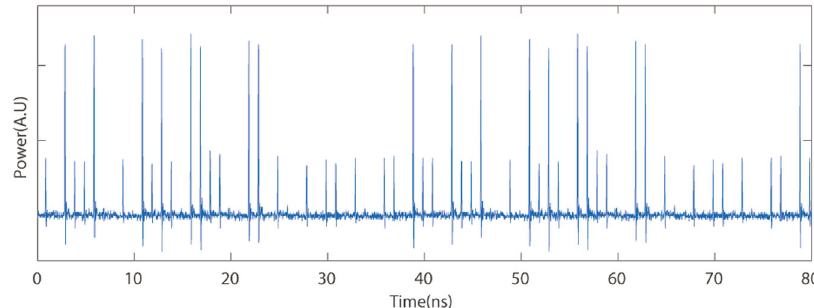
Fig. 6 Oscilloscope traces: a random sequence including μ s , μ d , μ v . The fi gure shows part of the recorded